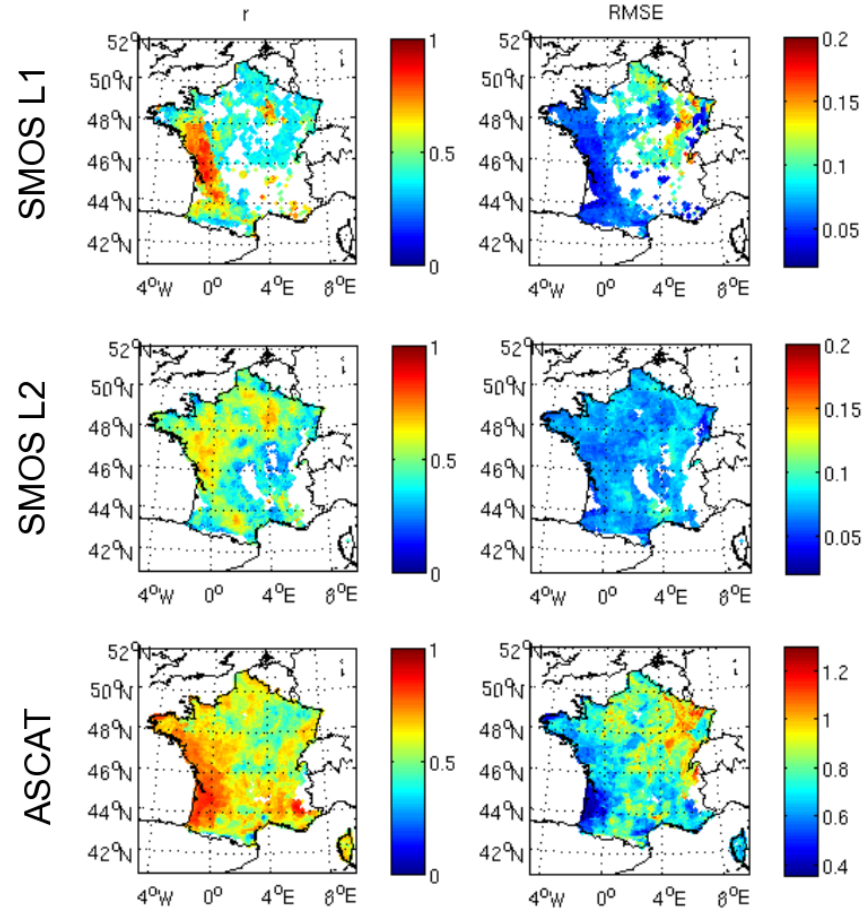
Fig. 7. Regression statistics of satellite vs. ISBA-A-gs SSM in 2010: (left panels) correlation coefficient ( r ) and (right panels) root mean square error (RMSE), of (top panels) SMOS-L1 with Eq. (2), (middle panels) SMOS-L2 with Eq. (3), (bottom panels) ASCAT with Eq. (4). The RMSE is expressed in m 3 m − 3 in the dynamic range of ISBA-A-gs for SMOS, and in dimensionless units for ASCAT.